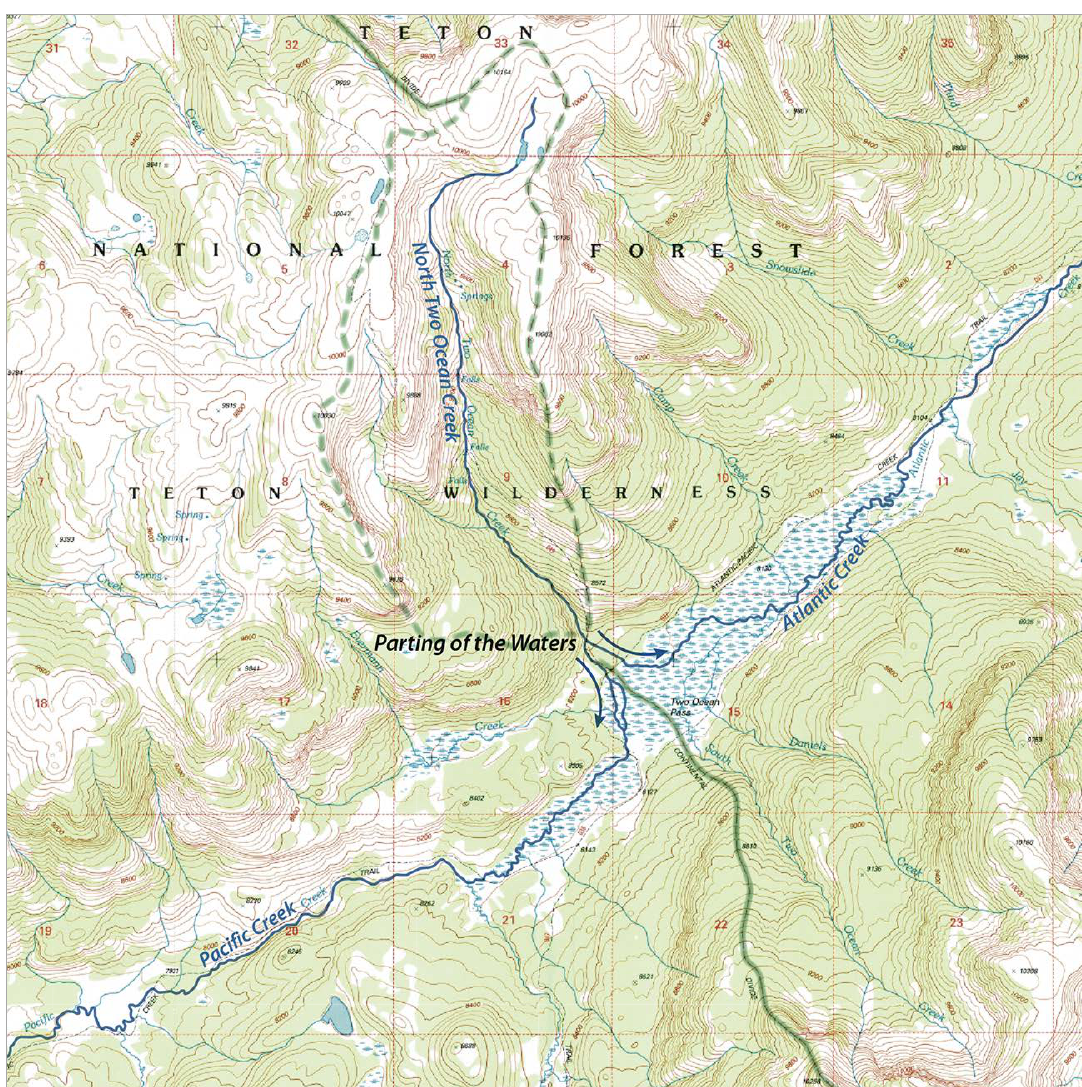
Figure A2. Modified portion of the U.S. Geological Survey, Two Ocean Pass quadrangle map for 2007 [109] showing the Parting of the Waters hydrological feature. North Two Ocean Creek flows along the Continental Divide and branches into Atlantic Creek, a Yellowstone River tributary flowing to the east, and Pacific Creek, a Snake River tributary flowing to the west. Scale (squares) is U.S. miles (1 mi = 1.61 km, 1 mi 2 = 2.59 km 2 ).